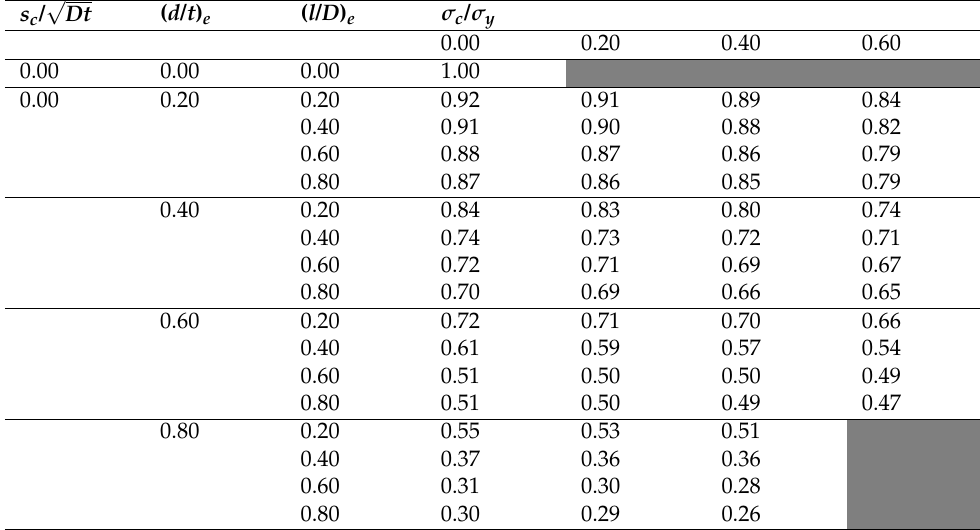
Table 10. Training data generated for the development of artificial neural network